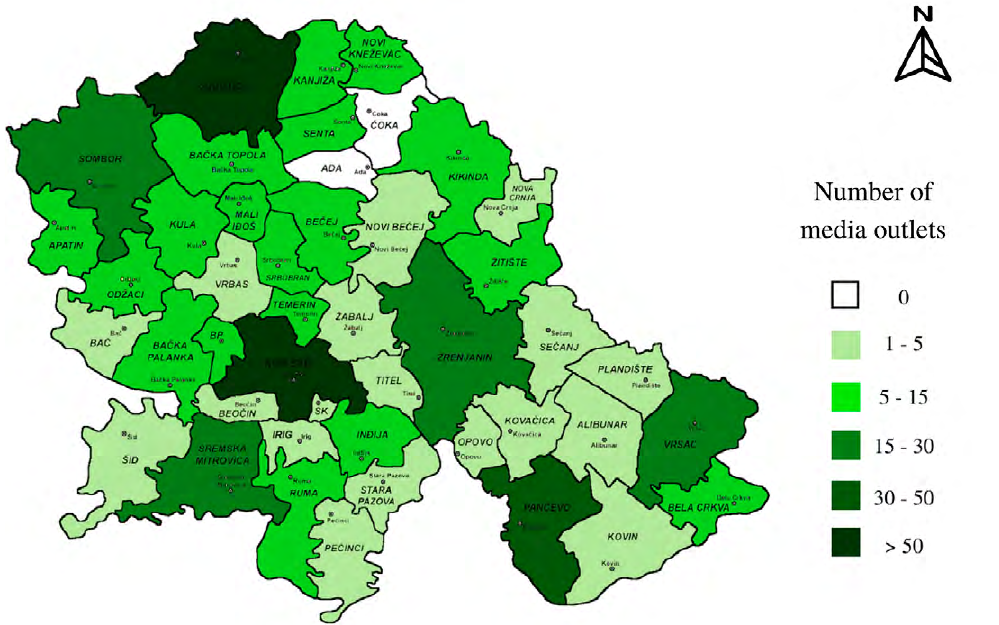
Figure 1. Number of media outlets in local self-governments in Vojvodina